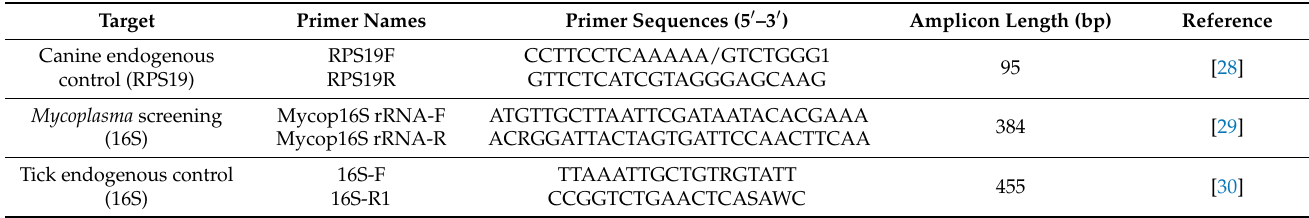
Table 1. Genes targeted by conventional PCR and primers used in this